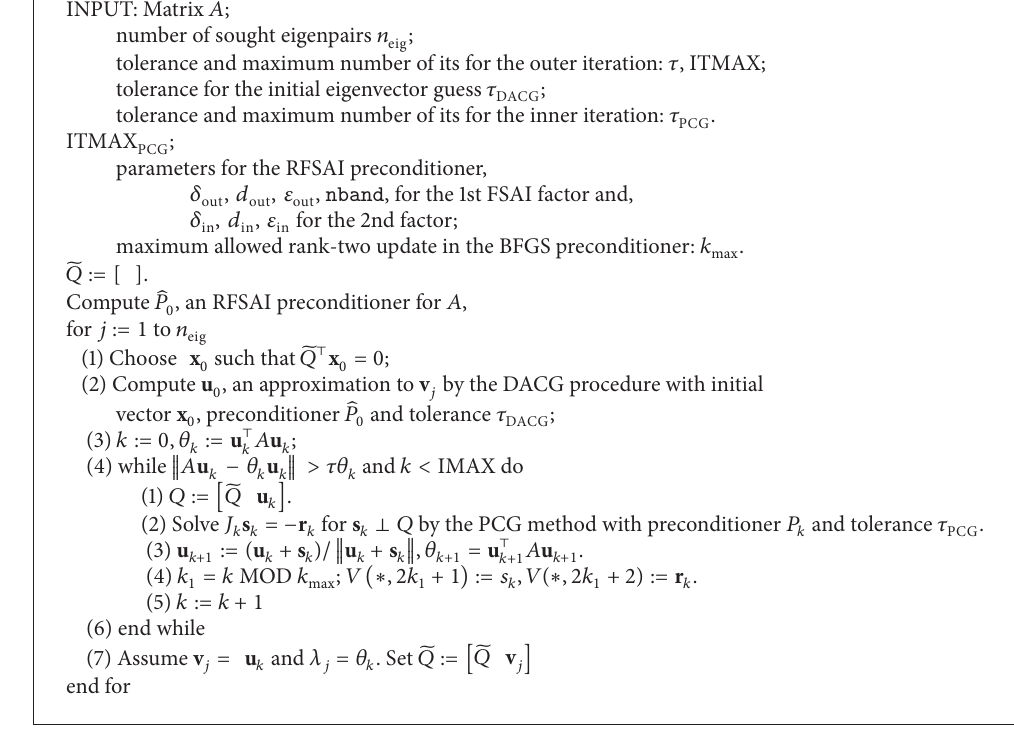
Algorithm 3: DACG-Newton